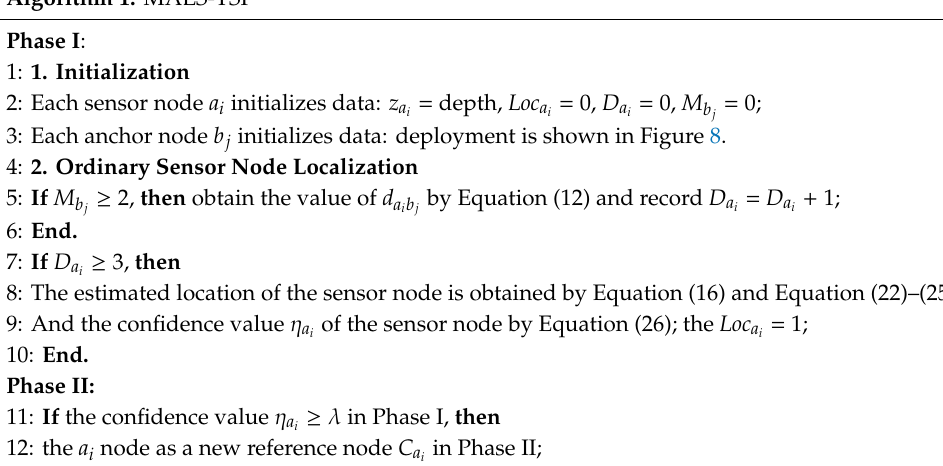
Algorithm 1: MALS-TSF